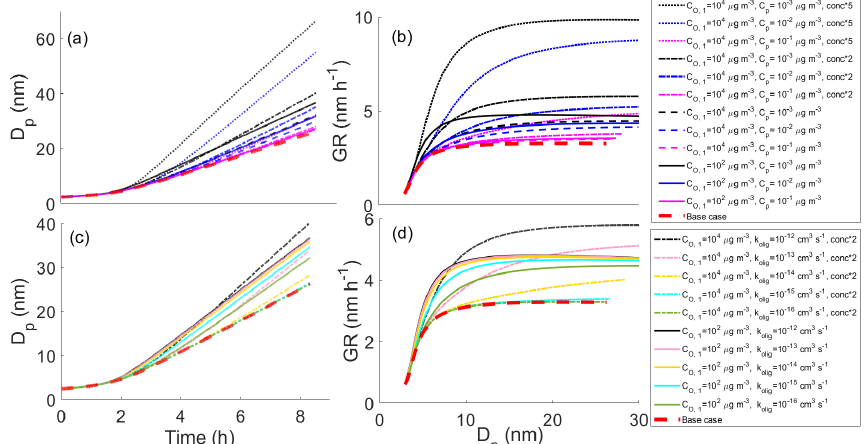
Figure 6. Diameter of a particle ( D p ) as a function of time (a, c) and growth rate (GR) of the particle as a function of diameter (b, d) in simulations in which we have altered the volatility and concentration of the highest volatility bin along with reference simulations. Panels (a) and (b) show the effect of gas-phase concentration and (c) and (d) the effect of the oligomerization rate coefficient. In each simulation, the highest volatility compound ( C ∗ either 10 2 or 10 4 µgm − 3 ) reacts with itself forming a lower-volatility compound. In (a) and (b) k olig = 10 − 12 cm 3 s − 1 (similar to Fig. 2c–f). The base case simulation in each panel describes the simulation without oligomerization